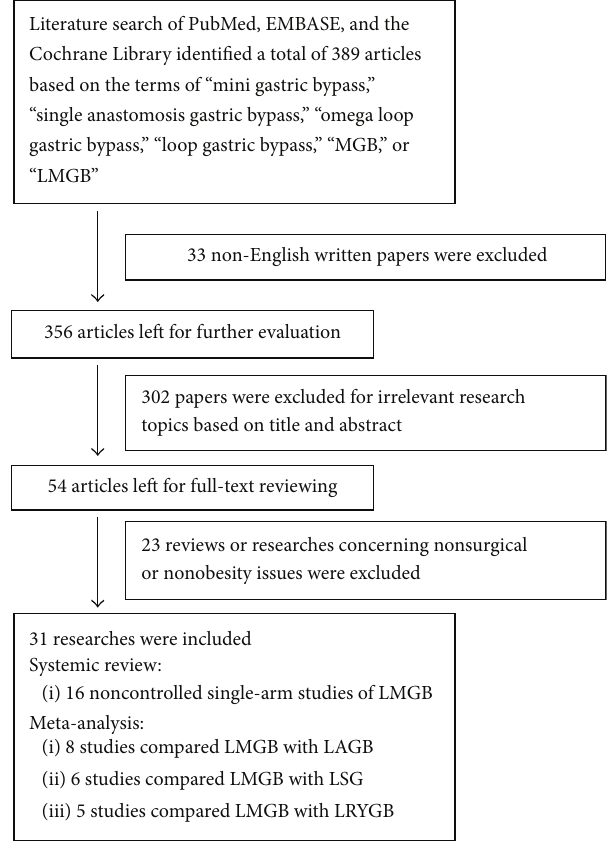
Figure 1: Flowchart of literature searching and study selection.